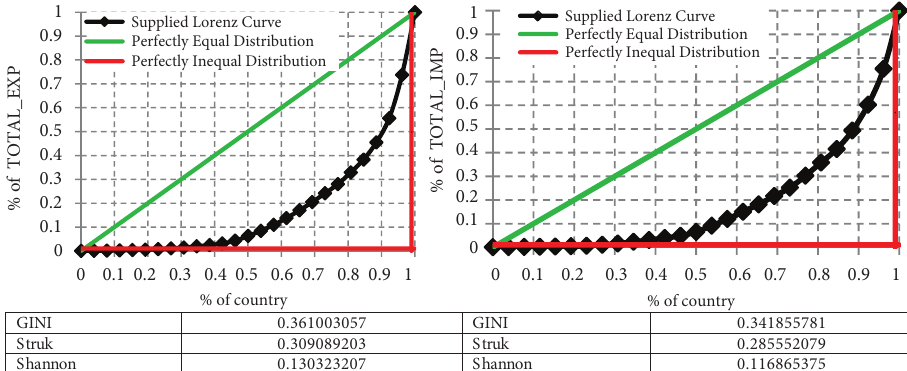
Figure 1. Concentration graph of Total exports and Total imports of Romania in EU, cumulated values, 2007–2016 (source: authors’ own computations) The main destinations for the TOTAL_EXP flows (54.53%) are Germany (26.27%), It- aly (18.15%), and France (10.11%). Following them is Hungary with 7.21%. The sources of TOTAL_IMP (50.66%) are Germany (24.58%), Italy (15.19%), and Hungary